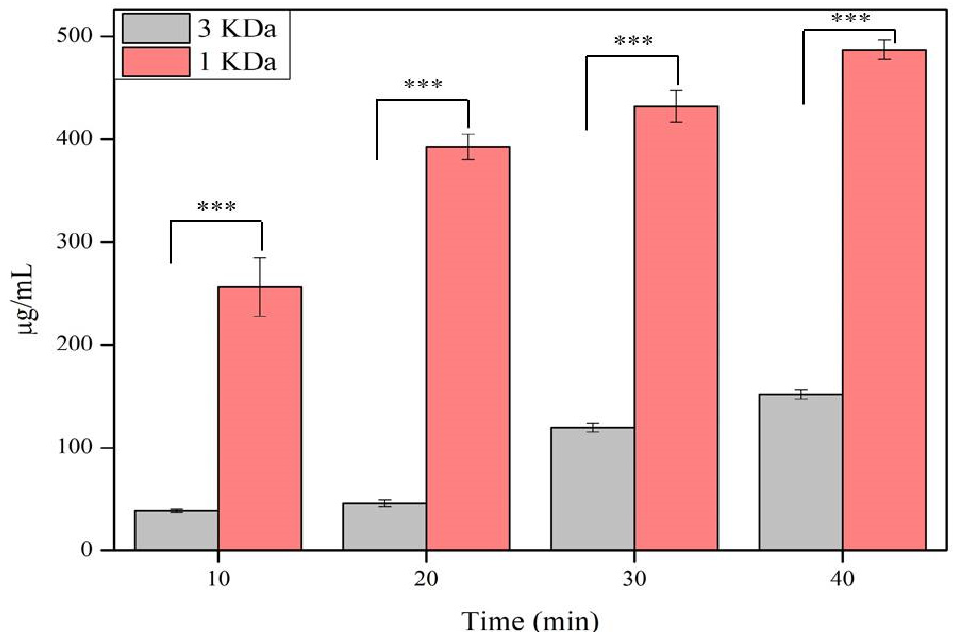
Figure 2. The concentration of collagen peptide in the buccal delivery film that permeated the buccal mucosa of swine as a function of the molecular weight and time. The changes were significantly different between 1 kDa and 3 kDa with p < 0.001 (***).